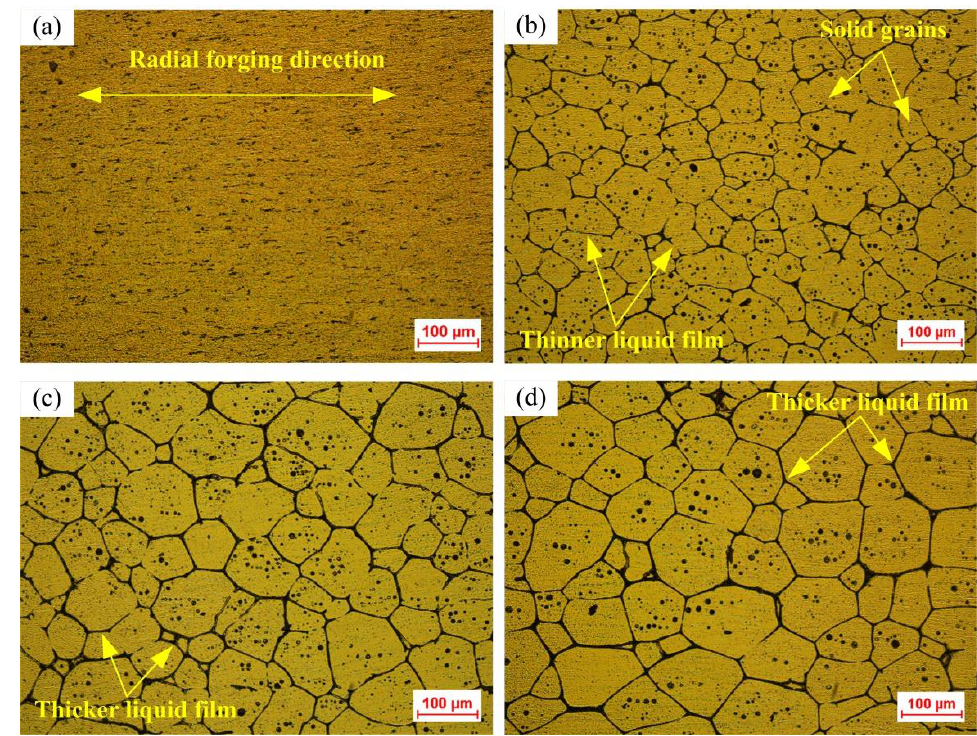
Figure 2. Microstructure of; ( a ) the cold radial forged 6063 aluminium alloy without SSIT, and semi-solid 6063 aluminium alloy after SSIT with the isothermal temperatures of; ( b ) 625 °C, ( c ) 630 °C, and ( d ) 635 °C.